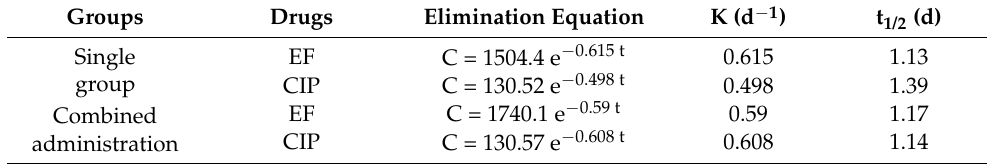
Table 8. Elimination parameters of EF in eggs.